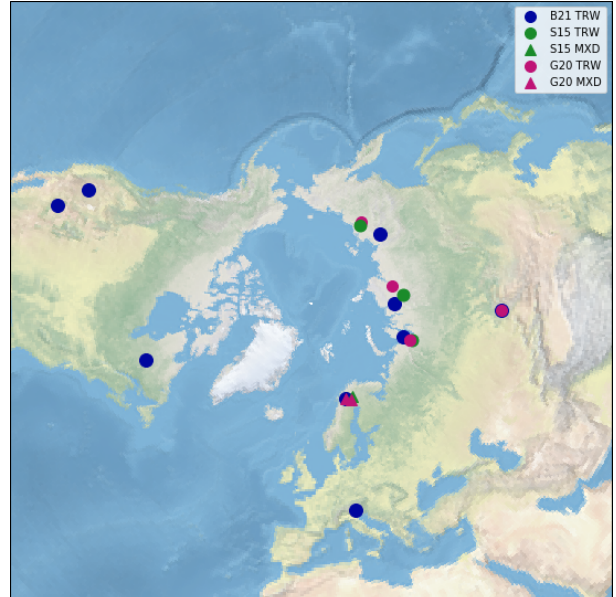
Figure A1. Locations of the Stoffel et al. (2015, green dots), Guillet et al. (2020, purple dots), and Büntgen et al. (2021, blue dots) tree ring sites. For more information see also Table A1. Tree ring width data are represented by the circles and maximum latewood density by